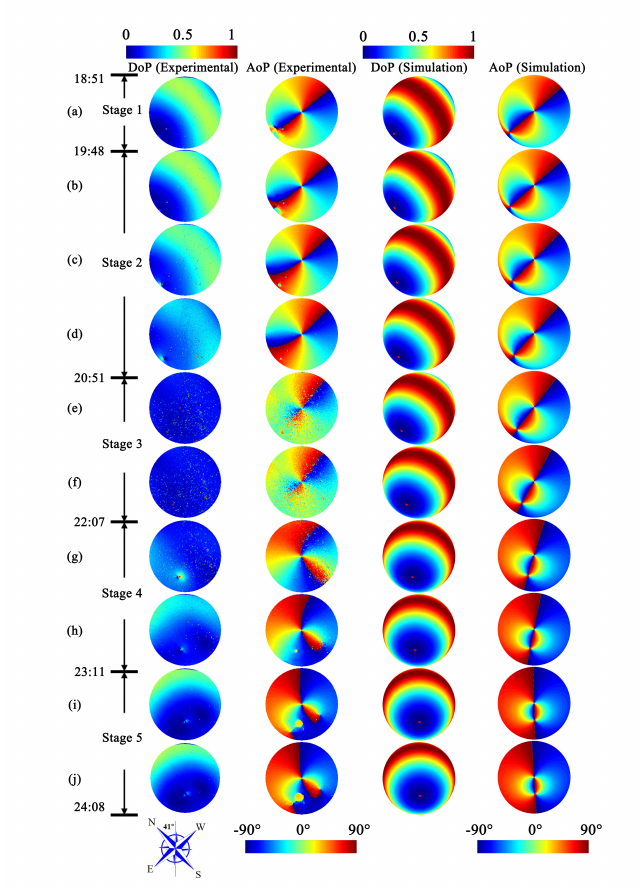
Figure 1. Chronological celestial polarization patterns ( a – j ) corresponding to the recording time on 31 January 2018 listed in Table 2. The Degree of Polarization (DoP; Table S1) and Angle of Polarization (AoP; Table S2) from the celestial patterns measured during the Super Blue Blood Moon (SBBM) are presented in the first and second columns, respectively. Ideal celestial polarization patterns of the DoP and AoP based on the single-scattering Rayleigh model were simulated at the same time and location as the first two experimental data columns. The time shown above is Local Time